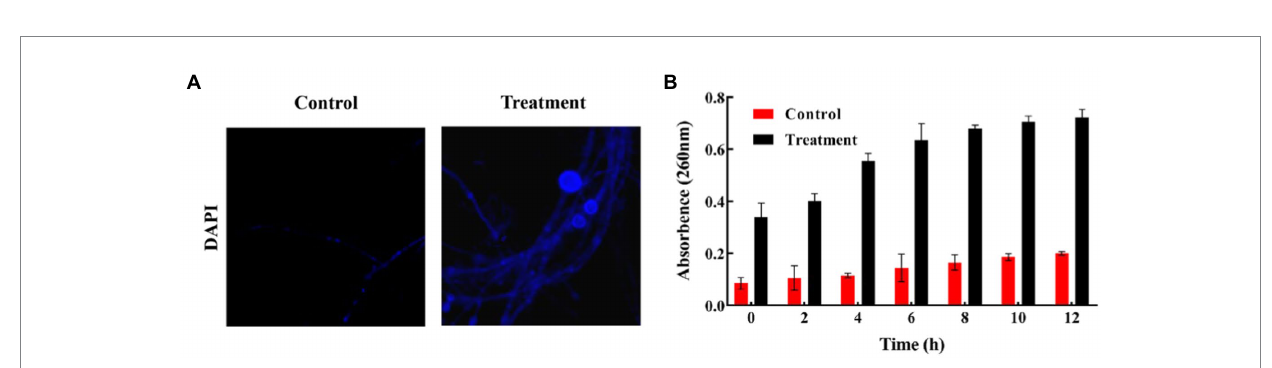
FIGURE 5 Effect of cell-free culture filtrate on the DNA fragmentation and leackages in Bipolaris sorokiniana cells. (A) cell-free culture filtrate produced by Bacillus amyloliquefaciens DB2 induced chromatin condensation in hyphal cells (×20). (B) Effects of cell-free culture filtrate on the nucleic acids of mycelium. Values are presented as mean ± SE ( n =